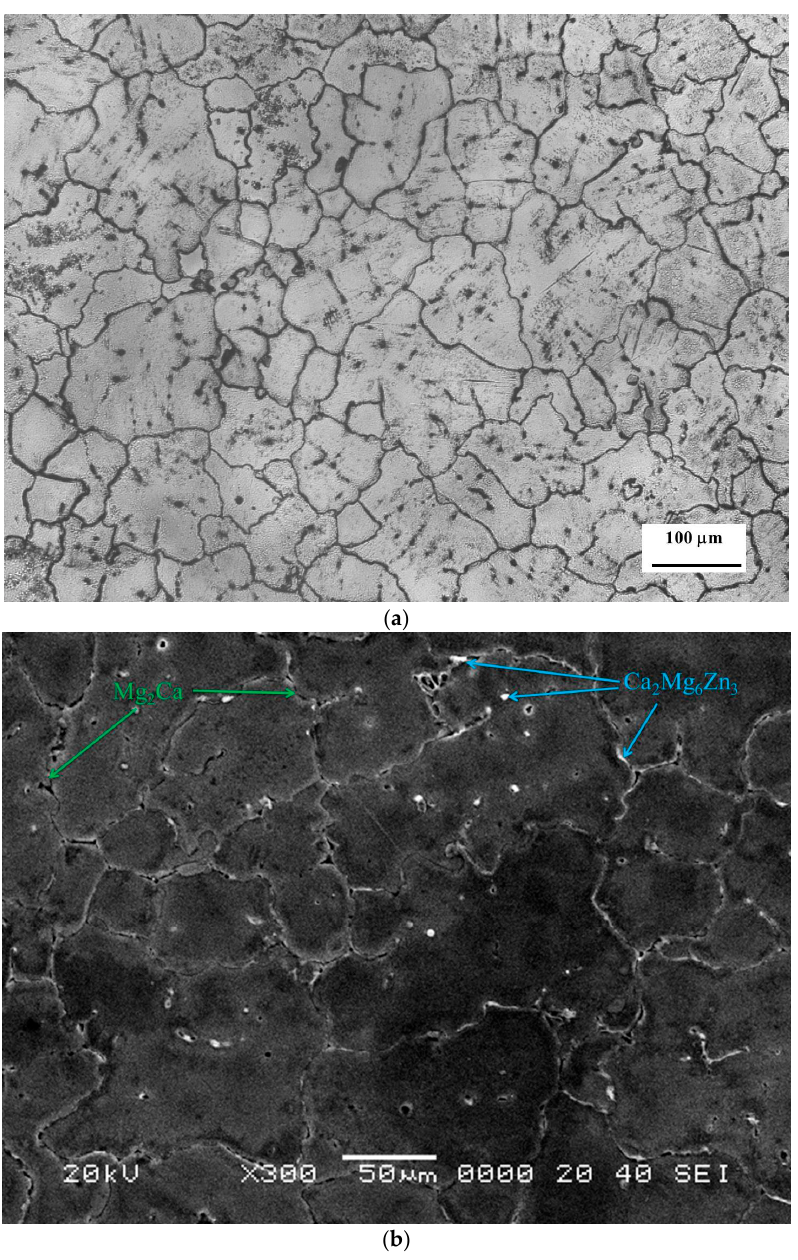
Figure 1. Initial microstructure of ZX11 (Mg–1Zn–1Ca) alloy in the cast condition: ( a ) Optical and ( b ) SEM (scanning electron microscope).